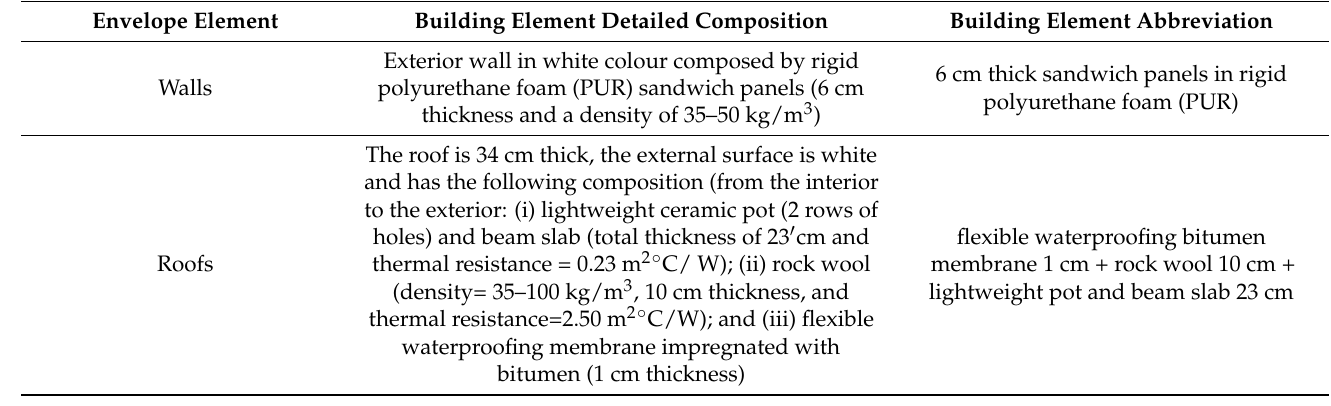
Table 2. Breakdown of the annual energy consumption of the case study’s main building systems.